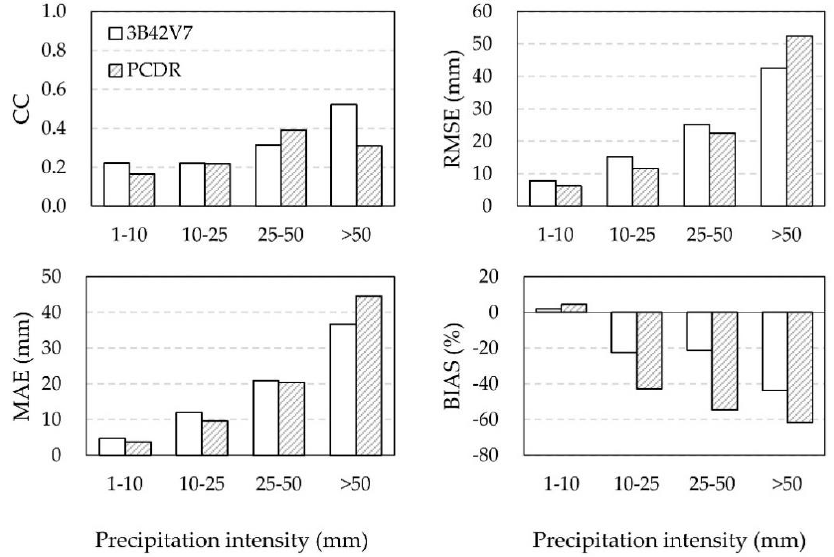
Figure 5. Statistical indices of 3B42V7 and PCDR data under different precipitation intensities at daily scale.